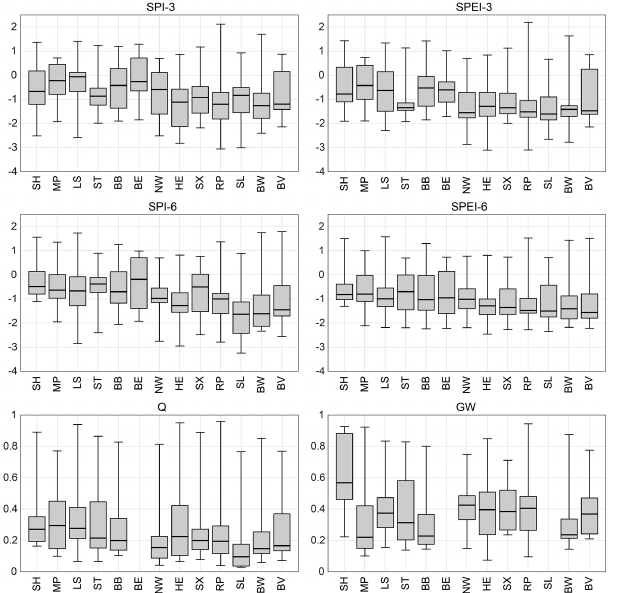
Figure 9. Germany: distribution of splitting values during random forest construction (i.e., thresholds of selected drought indicator variables for each NUTS1 region). Box plots as Fig. 8.